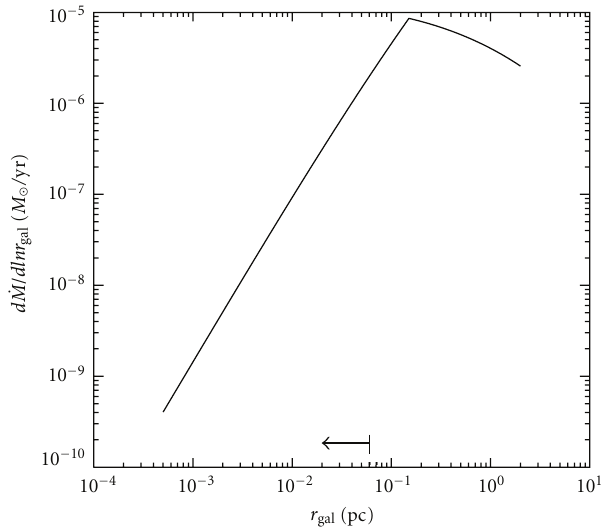
Figure 16: An upper limit to the mass loss rate due to collisions bet- ween RG and MS stars. The arrow indicates the range in the di ff use X-ray observations ( r gal < 1 . 5 (cid:3)(cid:3) ) which we use to constrain the PDMF (see Section